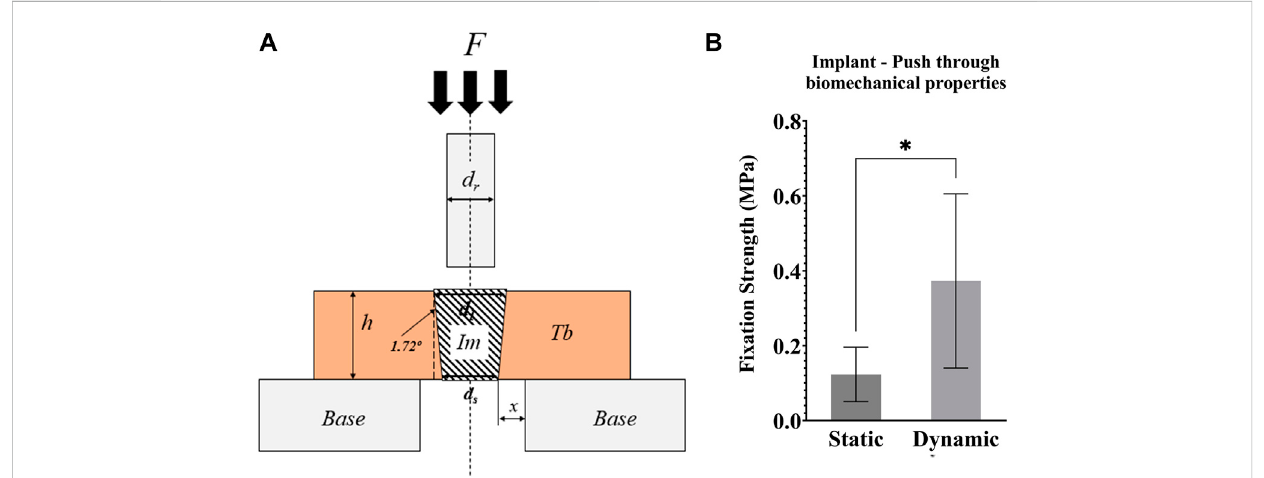
FIGURE 8 (A) Schematic representation of the push-through mechanical testing. Compression testing of all samples was performed after 21 days of culture. F=forceappliedtotheimplantwithacompressionplaten;Im=implant;Tb=trabecularbone;h=heightoftheTb;Base=supportofthebonecylinder; x = clearance of hole in the support base; ds = small implant diameter; dl = large implant diameter; dr = push-through rod diameter < dl (B) Graph of the push-through fi xation strength (MPa) comparing static and dynamic samples. * p < 0.05, ** p <